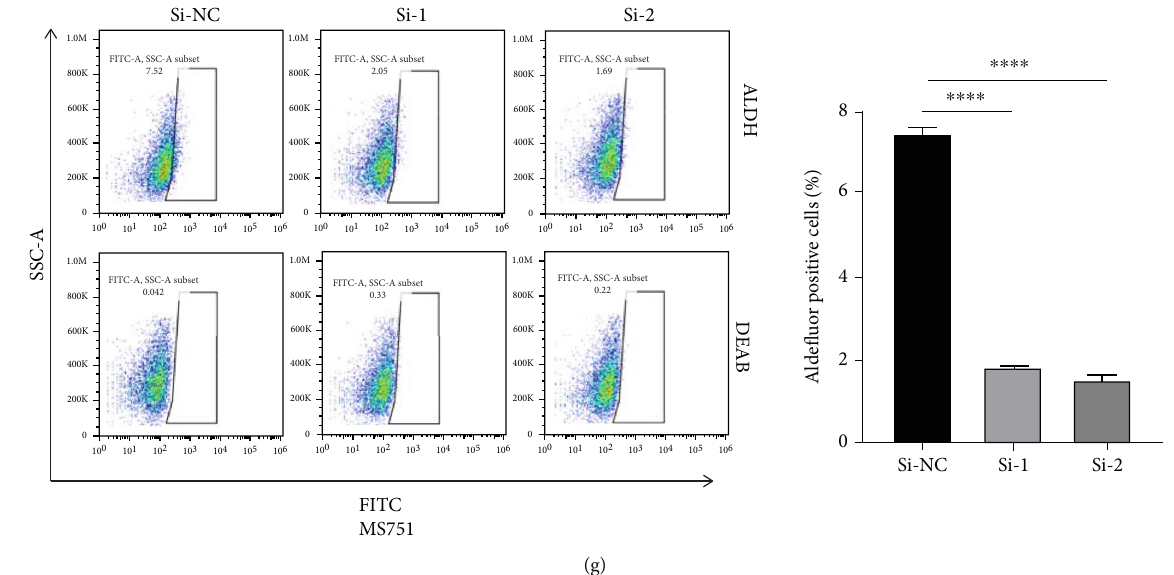
Figure 4: TAB2 knockdown inhibits the stemness of cervical cancer cells. (a) Protein levels of SOX2 and BMI1 were detected by Western blot after knockdown of TAB2 in Siha cells. (b) Protein levels of SOX2 and BMI1 were detected by Western blot after knockdown of TAB2 in MS751 cells. (c) TAB2 knockdown inhibited the sphere formation e ffi ciency in Siha and MS751 cells. (d) TAB2 knockdown inhibited the capacity of sphere formation in Siha cells. (e) TAB2 knockdown inhibited the capacity of sphere formation in MS751 cells. (f) ALDEFLUOR kit was used to assess the proportion of ALDH br in Siha cells intervened with TAB2 or not. (g) The ability of stemness maintenance in MS751 cells was assessed by ALDEFLUOR